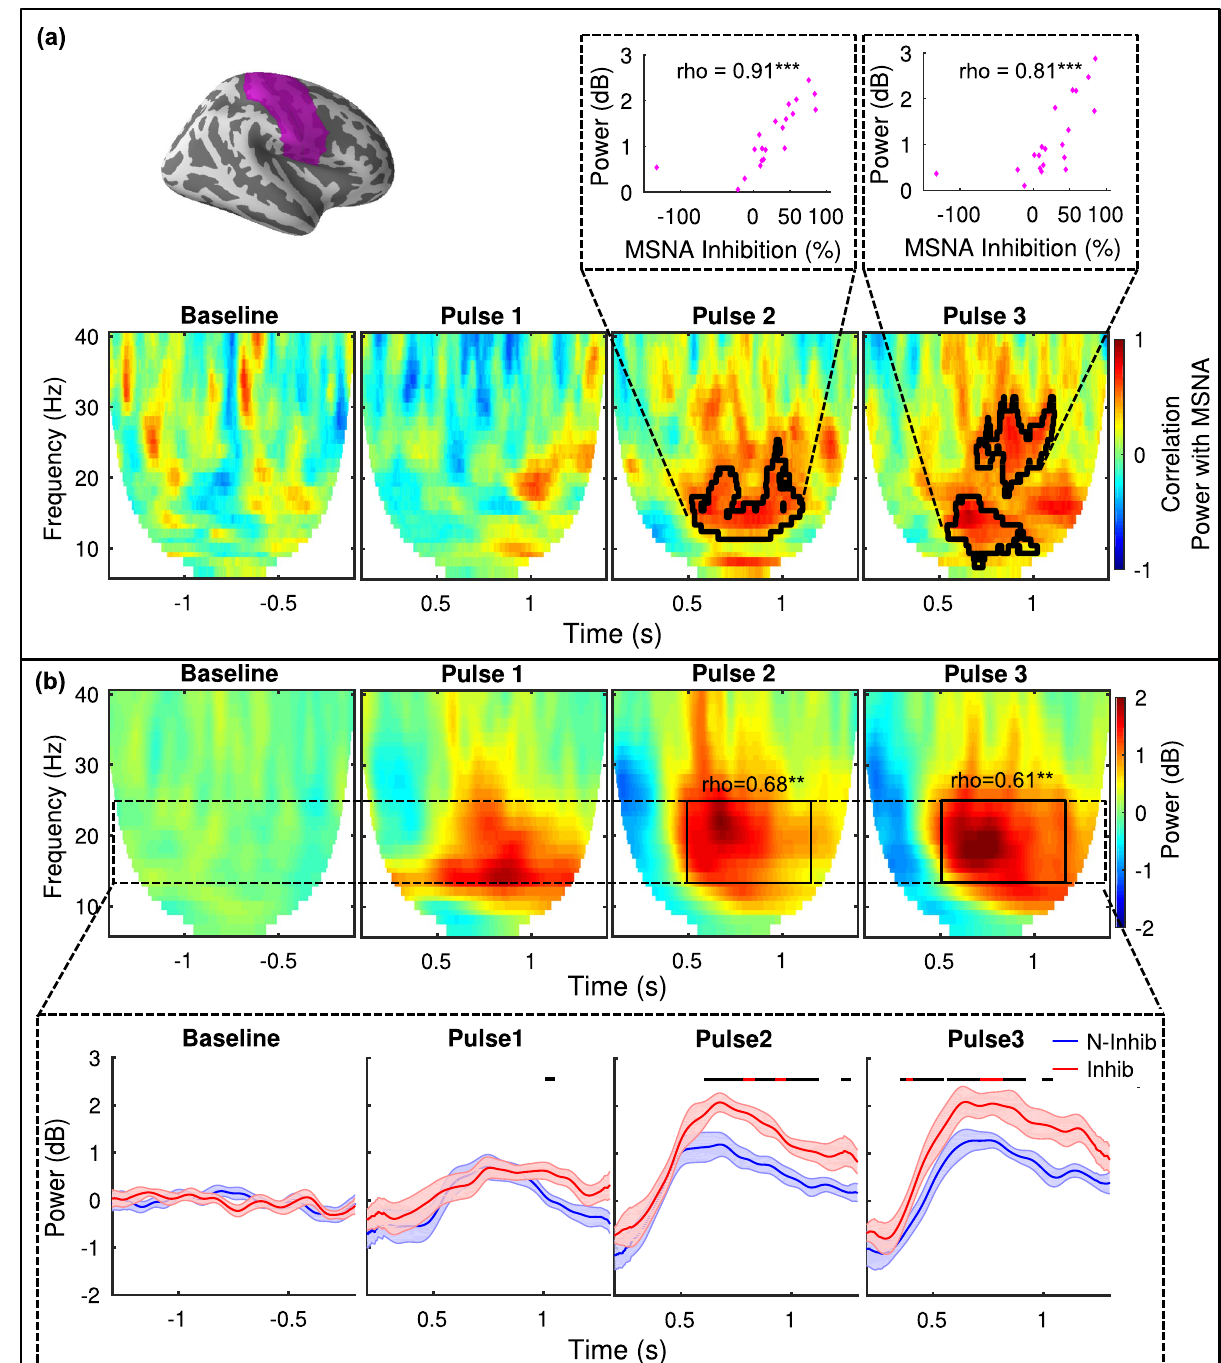
Figure 4. MEG neural oscillatory responses in the Rolandic sensorimotor cortex. All power is relative to pre- stimulus baseline (n = 20). (a) (top left) Rolandic ROI. Time–frequency maps of correlations between oscillatory power changes and individual MSNA inhibition values overlaid with above-threshold clusters. Correlations between average power within the clusters and MSNA inhibition is shown above for pulse 2 and pulse 3. (b) Grand average oscillatory power changes in the 5–40 Hz frequency range. The responses following all three pulses show early (0 to 0.4 s) beta desynchronization followed by beta rebound (0.5 to 1 + s). A general time– frequency window guided by the clusters in A is shown in black (0.5 to 1.2 s and 13–25 Hz) and average power therein correlates with individual MSNA inhibition (pulse 2: r s = 0.68, p = 0.001; pulse 3: r s = 0.61, p = 0.005). The average power over time in the beta frequency range (13–25 Hz, dotted windows) is shown below for Inhibitors (red, n = 10) and Non-inhibitors (blue, n = 10), shaded region shows SEM. Bars indicate regions of the time-scale containing a significant group difference (black: p < 0.05; red: p < 0.01). (** p < 0.01, *** p <